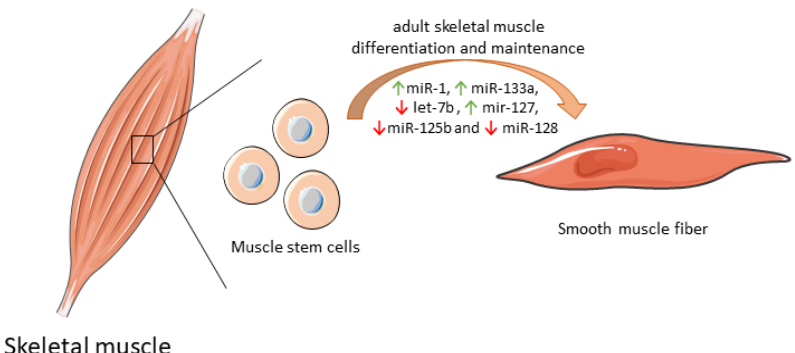
Figure 3. Differential expression of mitochondrial miRNAs impact adult skeletal muscle cell differentiation and maintenance. By modulating energy supply through mitochondria, these mitomiRs are able to promote the full di ff erentiation of muscle fibers. Increased expression of the mitochondrial gene is needed to promote an adequate mitochondrial performance and to allow more rapid responses to physiological needs, namely tissue